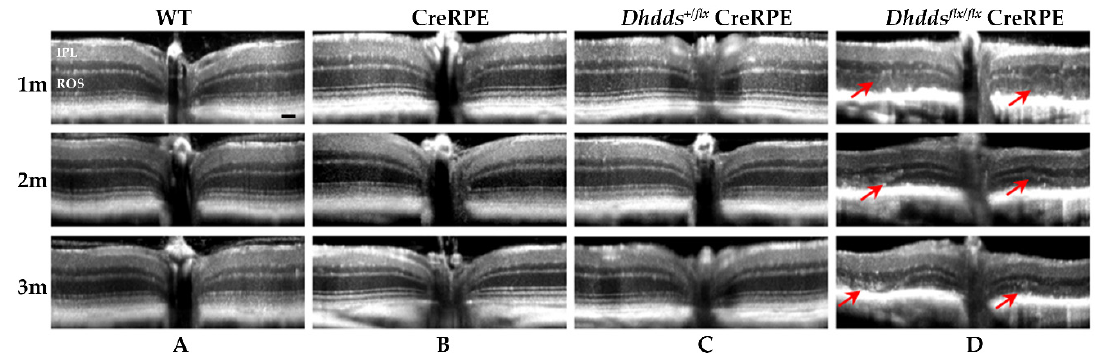
Figure 3. SD-OCT revealed structural changes in Dhdds flx / flx CreRPE mice at all ages. OCT scans were performed at 1, 2, and 3 months (m) postnatal for each genotype. ( A ) WT, ( B ) CreRPE, ( C ) Dhdds +/ flx CreRPE all showed normal layer stratification. ( D ) Dhdds flx / flx CreRPE showed alterations of hyper-reflectivity at all ages, indicative of pathologic changes (red arrows) and reduction in layer thickness, particularly in the outer retina. IPL, inner plexiform layer, ROS, rod outer segment. Scale bar (shown in WT 1 m panel): 50 µ m, applies to all panels.